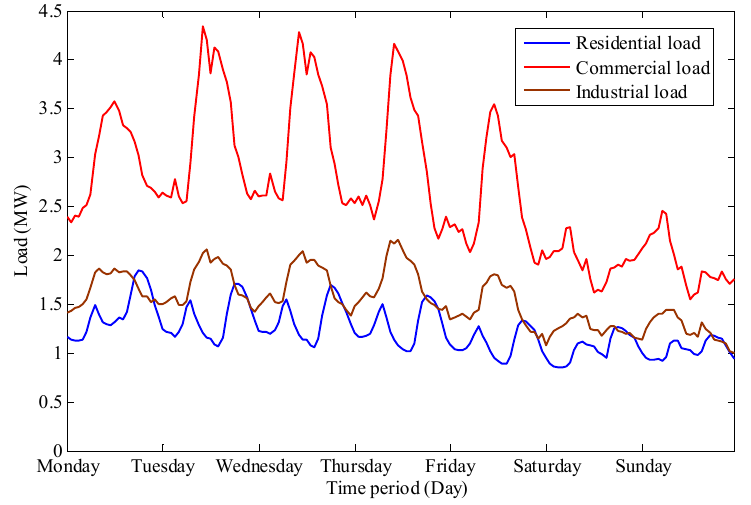
Figure 2. Three types of typical weekly load curves.